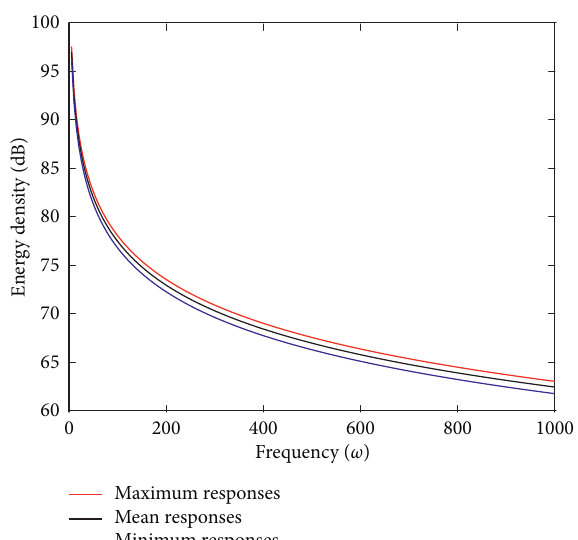
Figure 12: Energy density interval of the beam with a random-location excitation in the frequency field. The reference energy density is 10 − 12 J/m 2